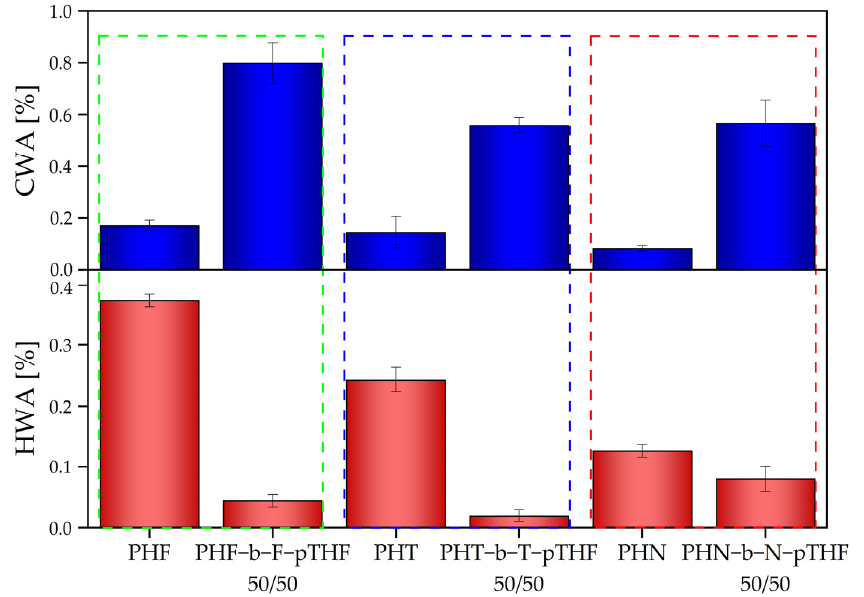
Figure 7. Water absorption in the hot and cold water of PHF, PHT, PHN, PHF-b-F-pTHF 50/50, PHT-b-T-pTHF 50/50, PHN-b-N-pTHF 50/50.